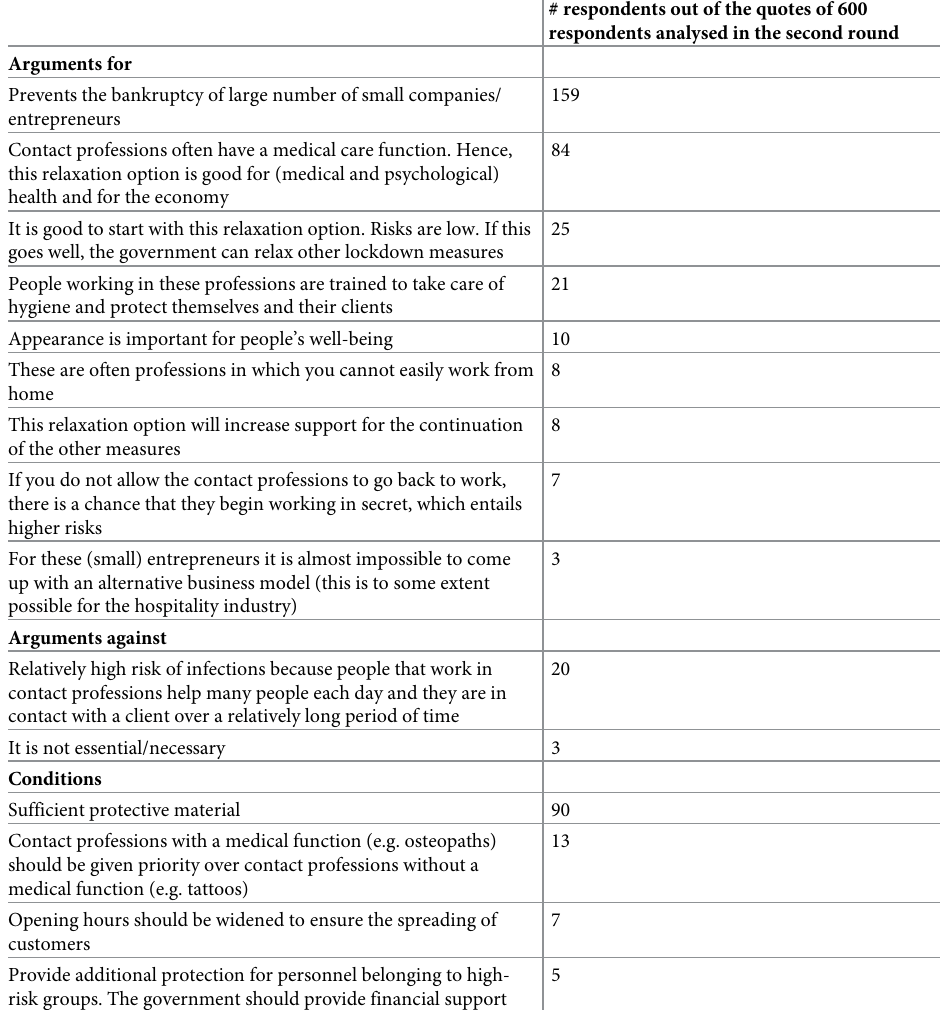
# respondents out of the quotes of 600 respondents analysed in the second round